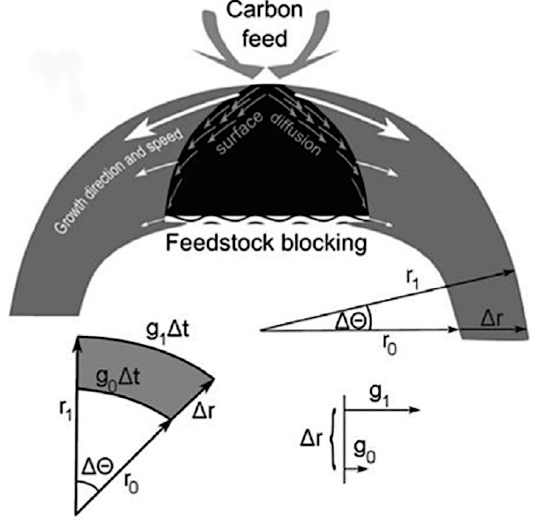
Figure 16. Drawings of the two-dimensional b-TCF growth model with hemisphere-like catalyst and feedstock blocking [30]. Reprinted with permission from [30], Copyright 2011